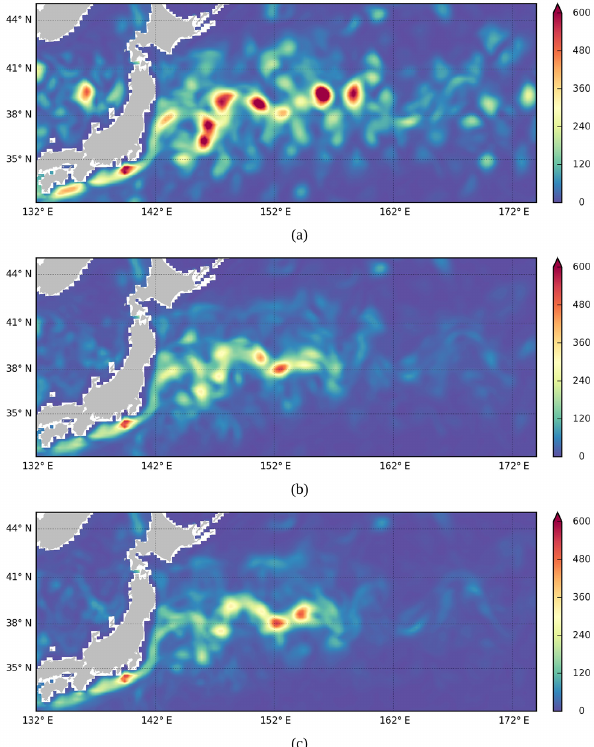
Figure 8. KU 7-day forecast MSE of SL in cm 2 for Sat1 (a) , Sat2 (b) and Sat3 (c) .